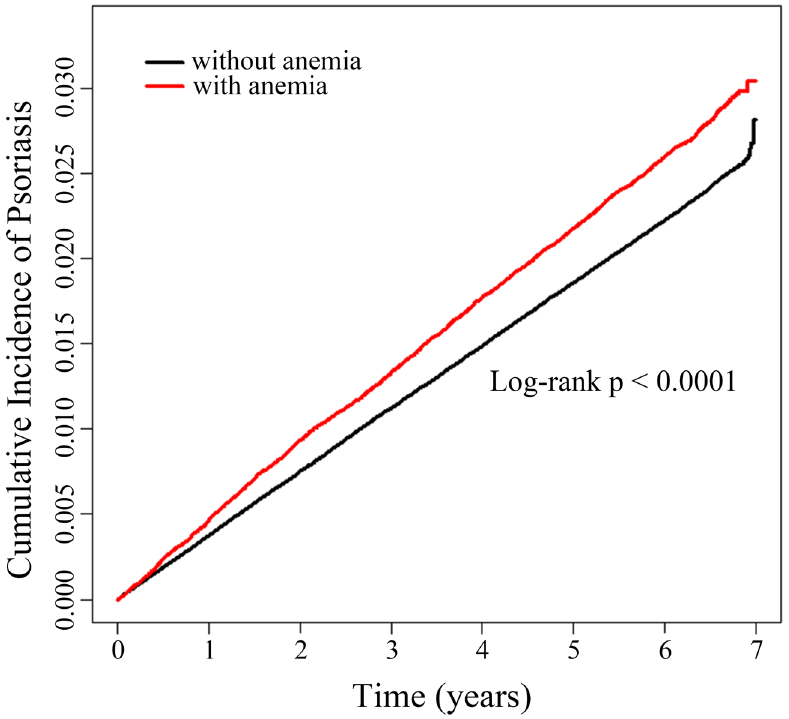
Figure 1. Cumulative incidences of psoriasis according to the presence of anemia in patients with chronic kidney disease.